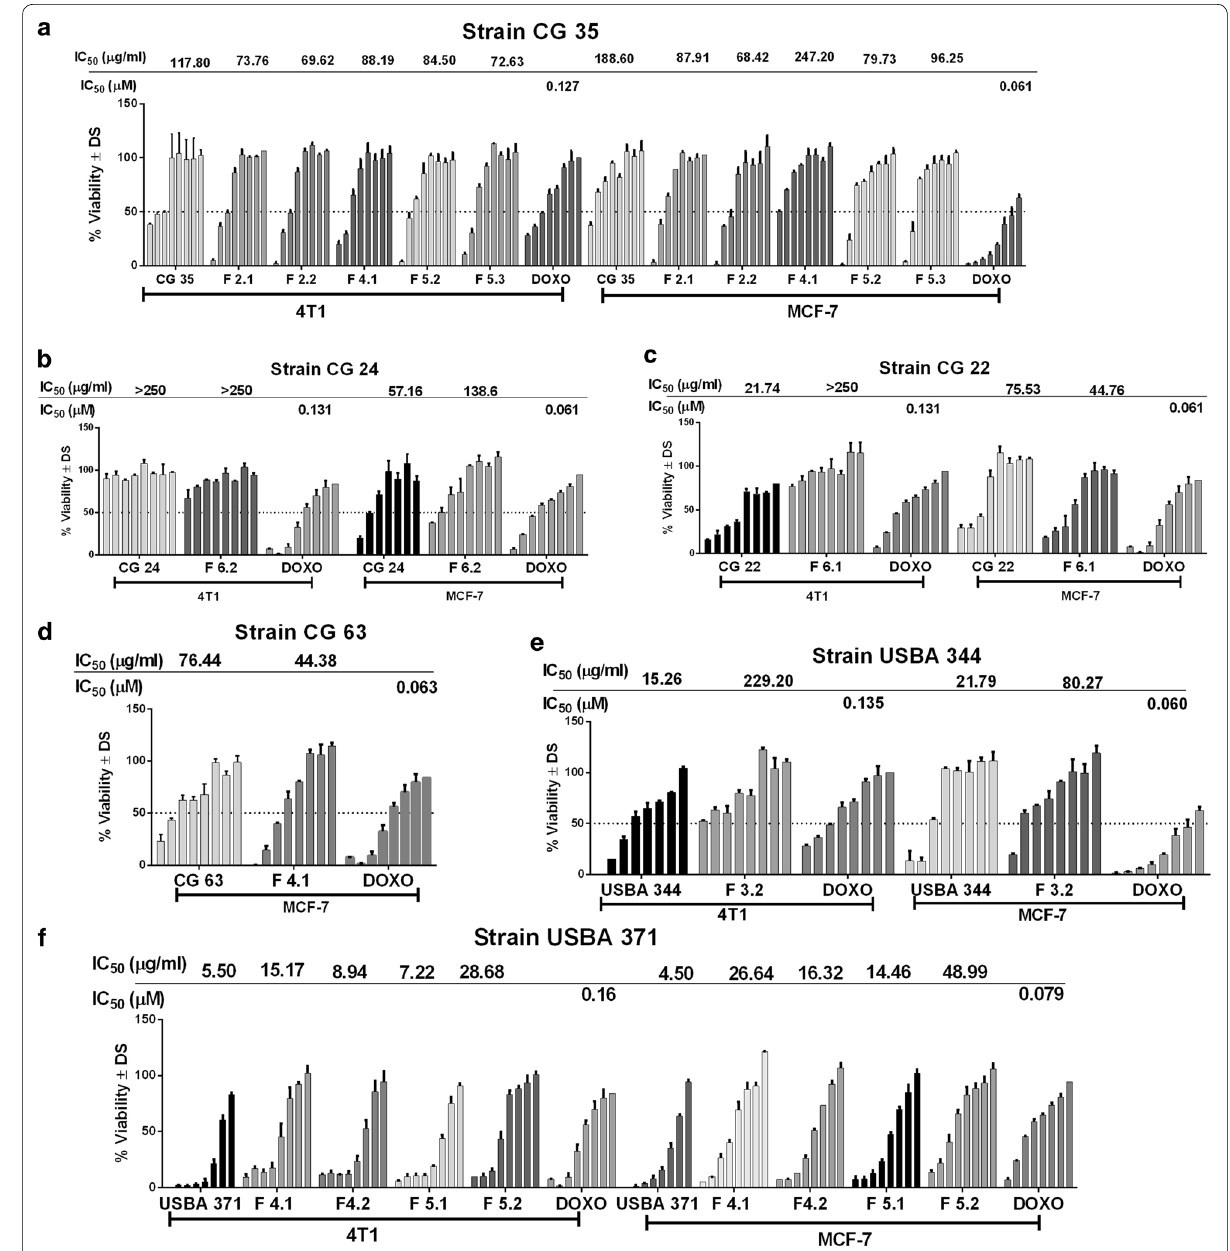
Fig. 3 Cytotoxic effects and IC 50 of crude extracts and fraction from strains CG 35 ( a ), CG 24 ( b ), CG 22 ( c ), CG 63 ( d ), USBA 344 ( e ), and USBA 371 ( f ) on the adherent murine mammary cell carcinoma 4T1 and human mammary adenocarcinoma MCF‑7 cell lines. IC 50 was performed using eight dilutions ranging from 250 to 31.25 μg mL − 1 . DOXO Doxorubicin at concentration of 5 μM was used as a positive